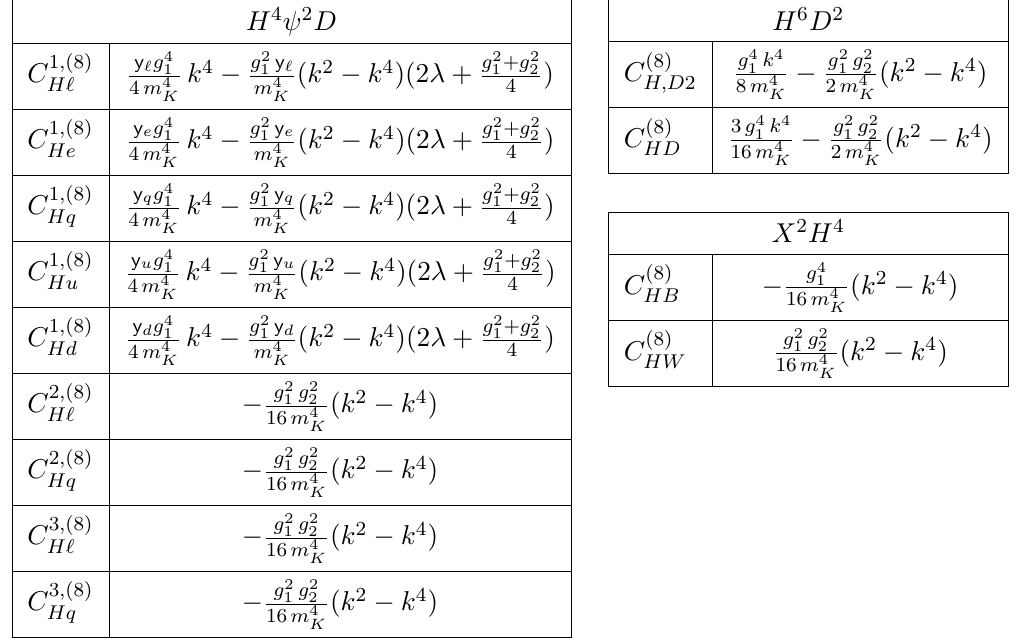
Table 9 . Matching coefficients onto operators in L (8) [16]. In the U(1) model, in addition to these matching contributions, there are four-fermion operators and four-point